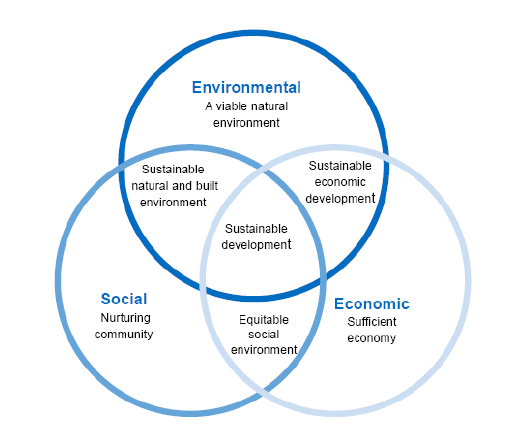
Figure 1. The main components of sustainable communities Source: URL1